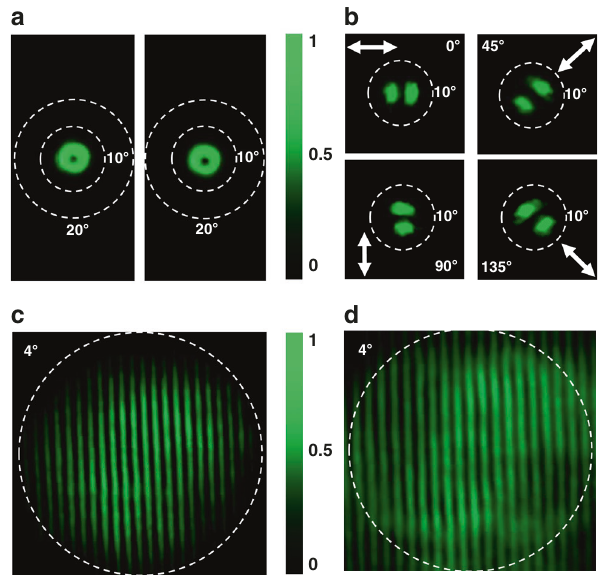
Fig. 2 The far- fi eld characteristics of perovskite bullseye VCSELs. a The beam pro fi les of bullseye VCSEL recorded in the forward direction and backward direction. The white dashed circles represent 10° and 20° as an angular scale bar. b The polarization state of the donut shaped laser beam after a linear polarizer. c , d The self-interference patterns of the forward and backward donut, respectively. The white dashed circle corresponds to the angle of 4 degree. Here the pump fl uence is 20.5 μ J/cm 2 .